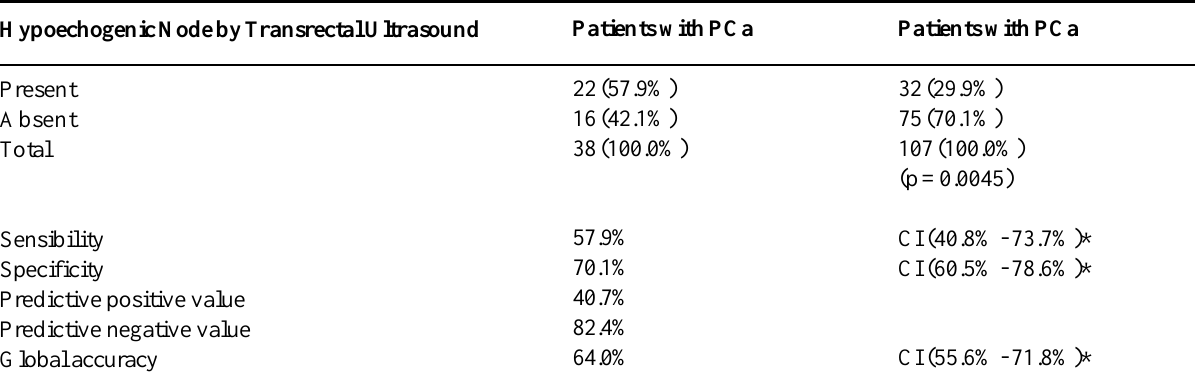
Table 4 – Relation between the presence of hypoechogenic nodes in the prostate peripheral zone by transrectal ultra- sound and PCa diagnosis.